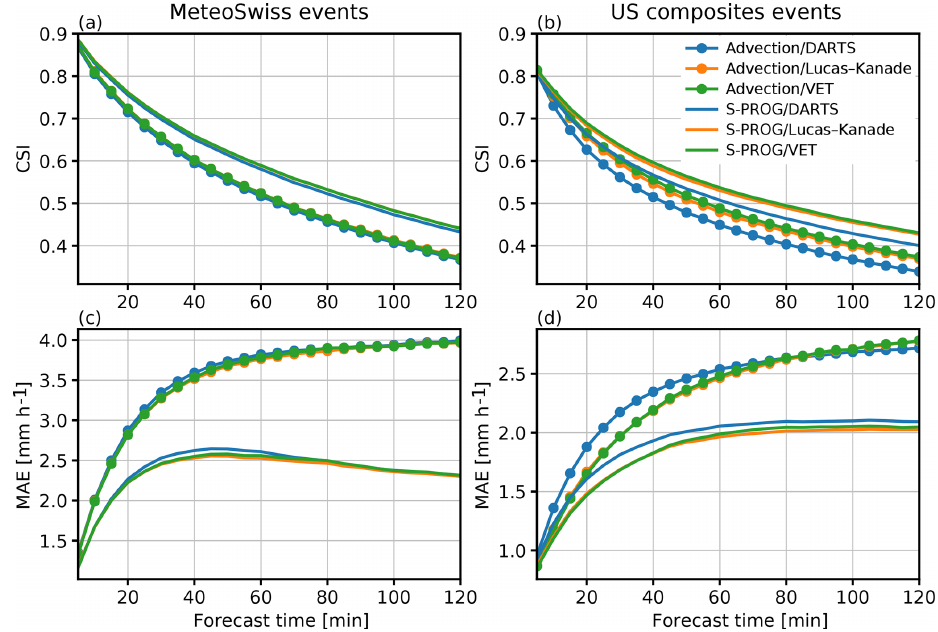
Figure 11. Comparison of forecast skill using different optical flow and extrapolation methods. Panels (a) and (c) show the averaged CSI and MAE for the MeteoSwiss events listed in Table 8, while (b) and (d) show the same results but for the US events listed in Table 9. The CSI is computed using a 0.1mmh − 1 threshold.